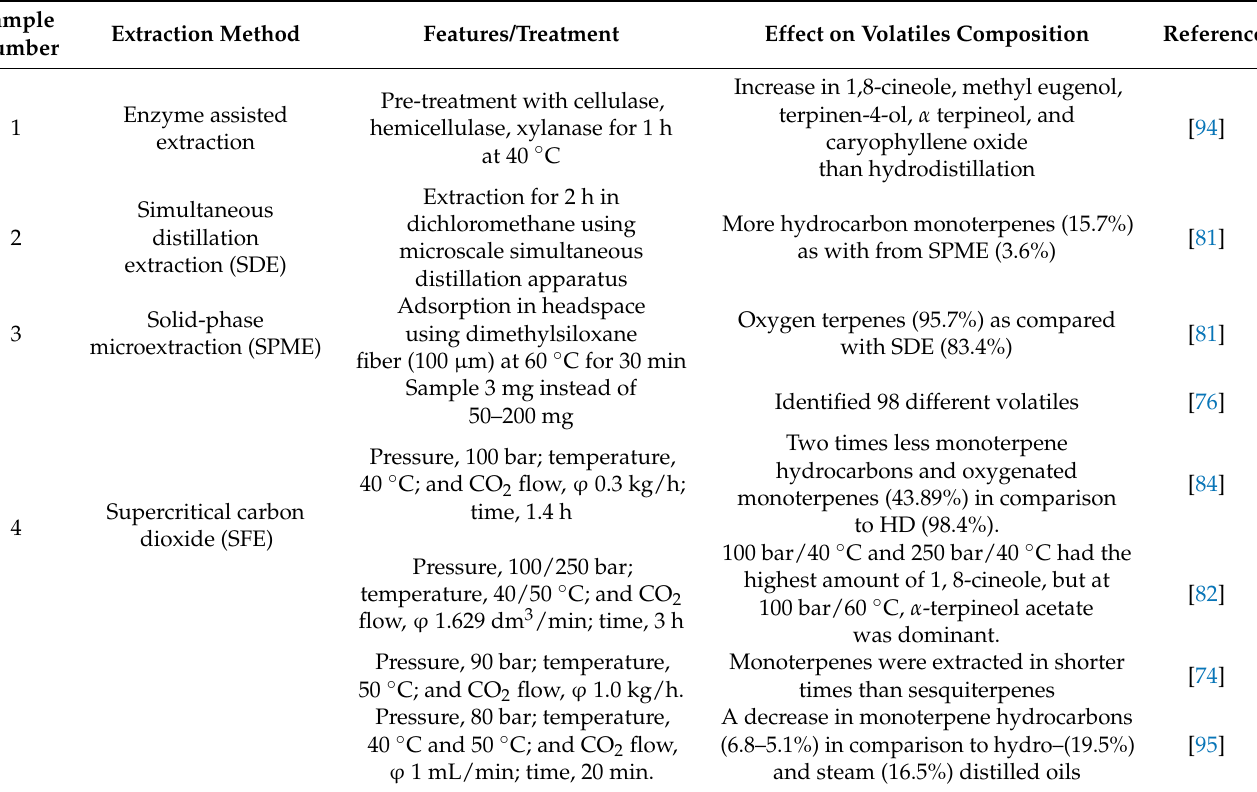
Table 3. Comparative studies of improved extraction methods and their effect on volatile composition in Laurus nobilis